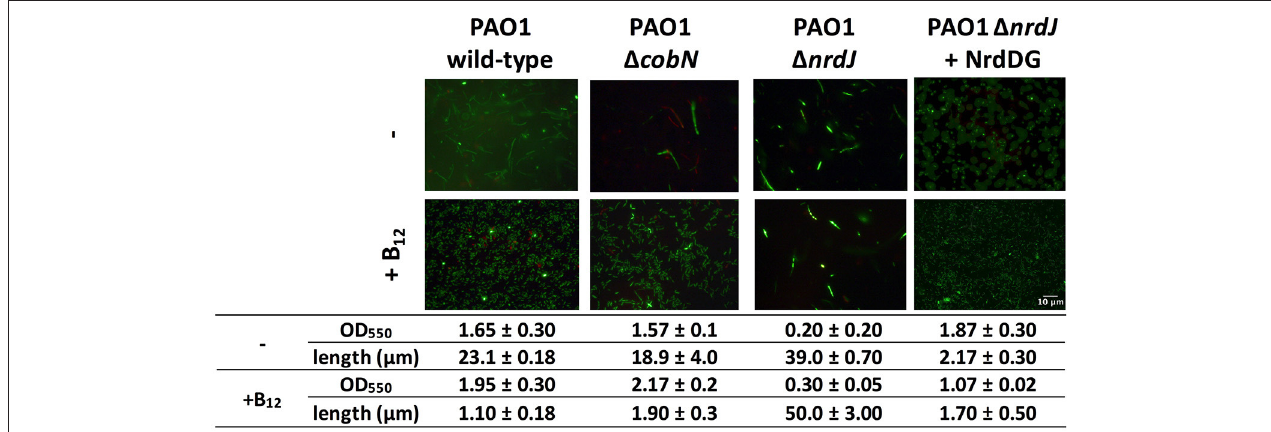
FIGURE 4 | CobN is not involved in P. aeruginosa PAO1 anaerobic growth. Fluorescence microscopy pictures of P. aeruginosa PAO1 wild-type, 1 cobN , 1 nrdJ , and 1 nrdJ + NrdDG cells stained with the LIVE/DEAD BacLight Bacterial Viability Kit at 16h of anaerobic growth in MM ± vitamin B 12 . The length was measured using ImageJ software. Scale bars, 10 µ m.